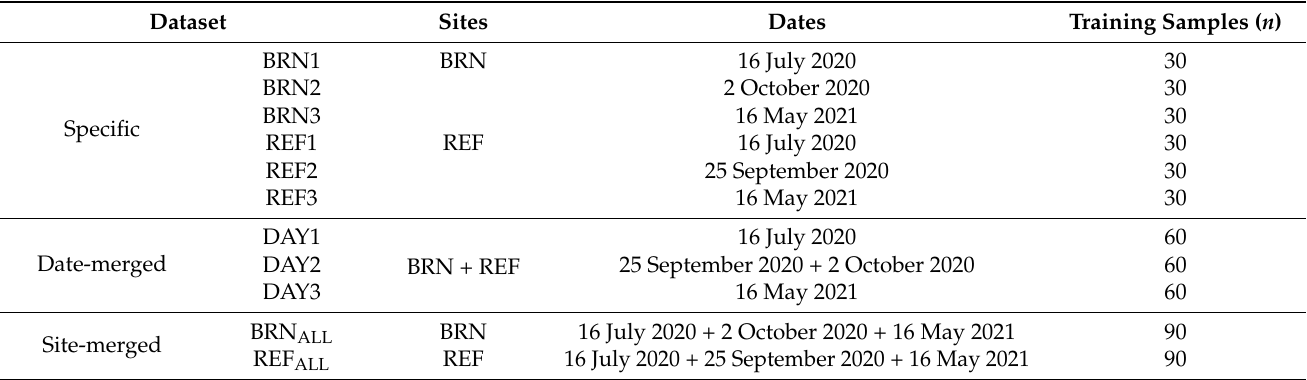
Table 3. Description of the datasets used for predicting soil moisture and their respective sample